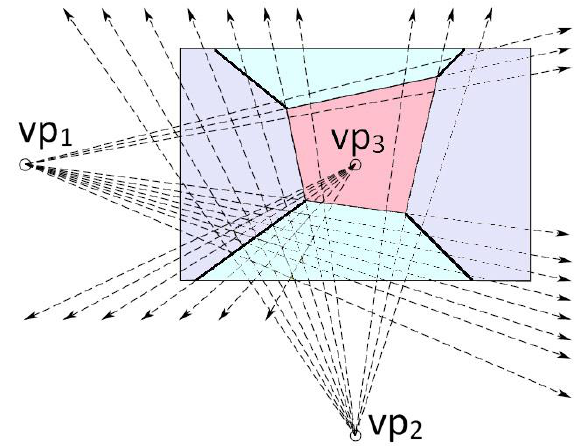
Figure 3. Creating key box Layout hypothesis by intersecting line segments (solid lines) and created virtual rays (dashed lines) using vanishing